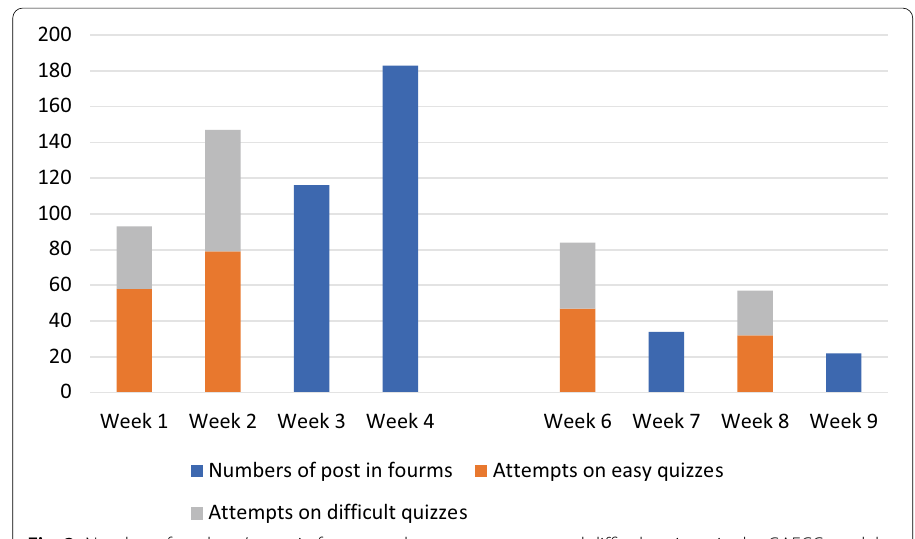
Fig. 2 Number of students’ posts in forums and attempts on easy and difficult quizzes in the GAFCC